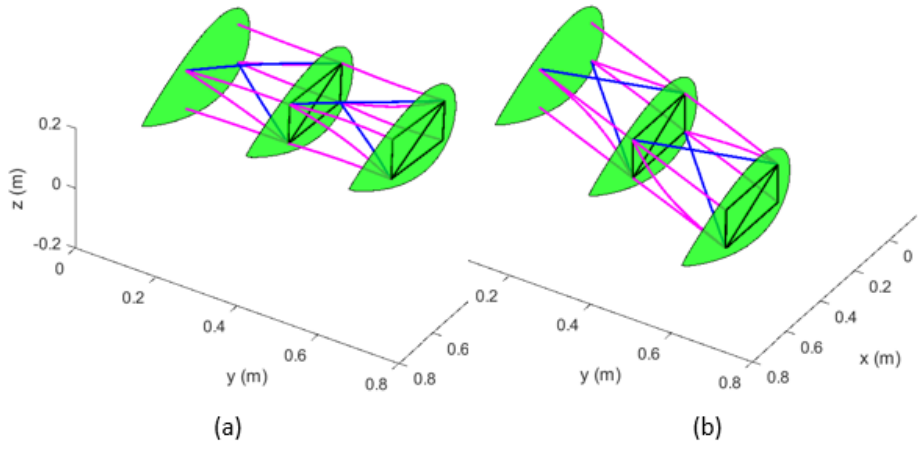
Figure 18. Tenth mode shape for the system in the ( a ) un–morphed configuration, ( b ) morphed configuration (simulation